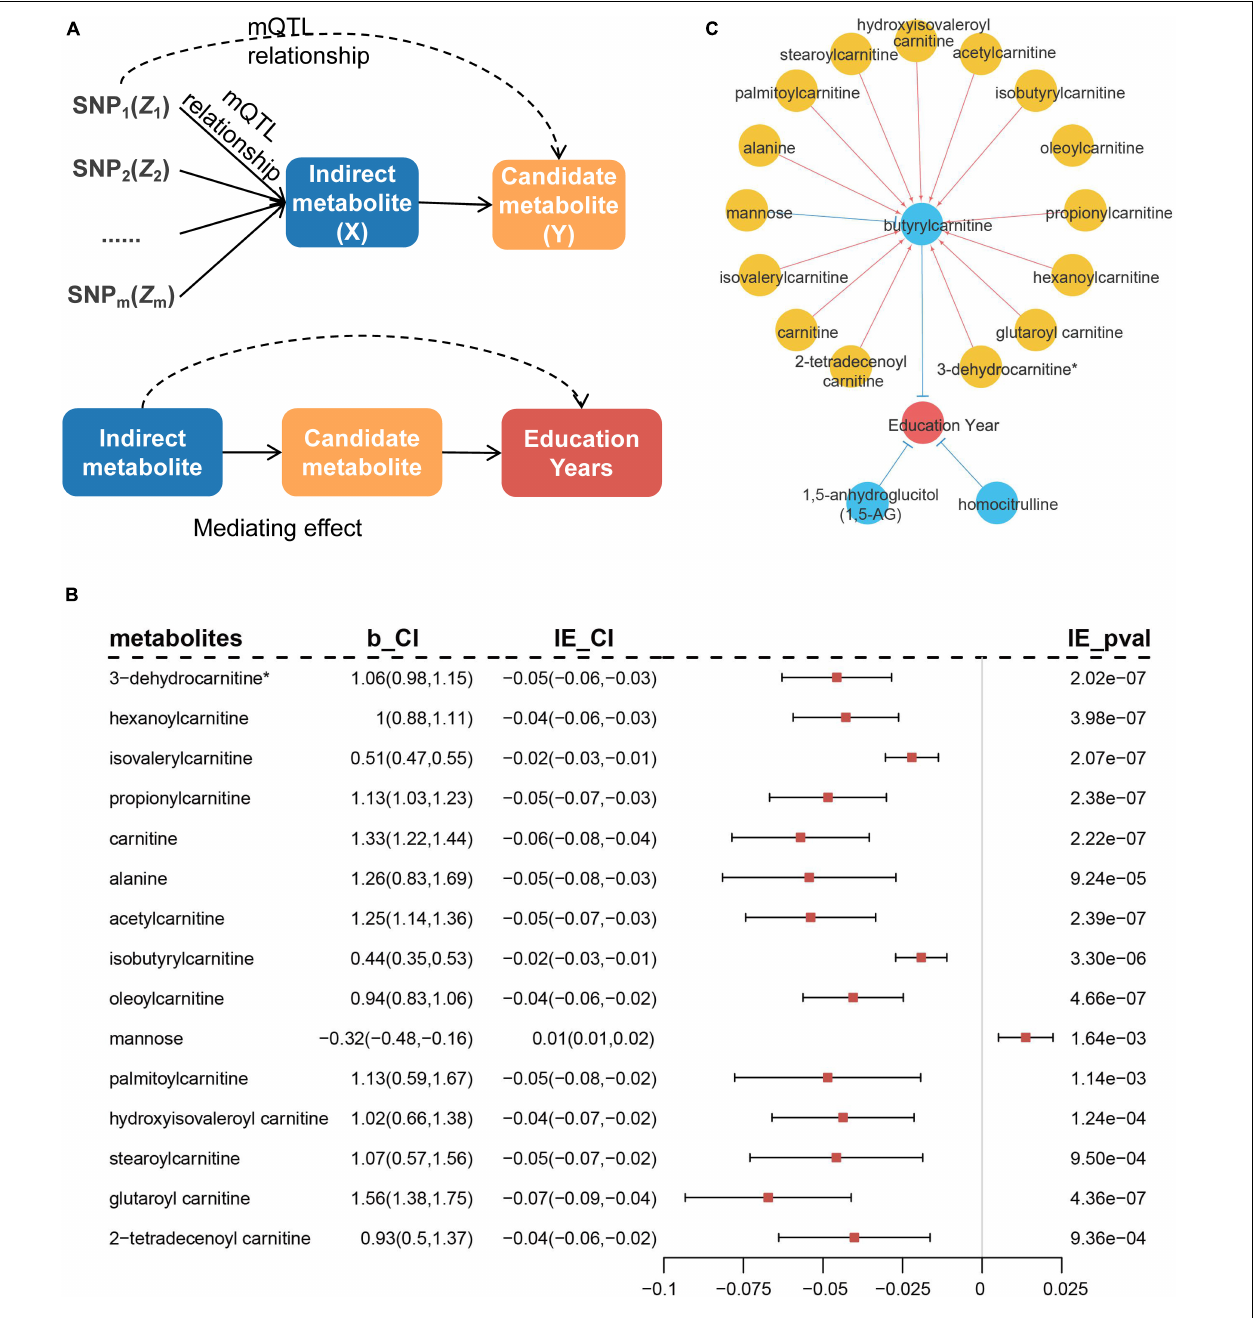
( Supplementary Figure 5B ), which in turn lead to different statistics ( Supplementary Figure 5C ). This may explain why the bias and MSE of MR-RIVER and IVW are similar, but